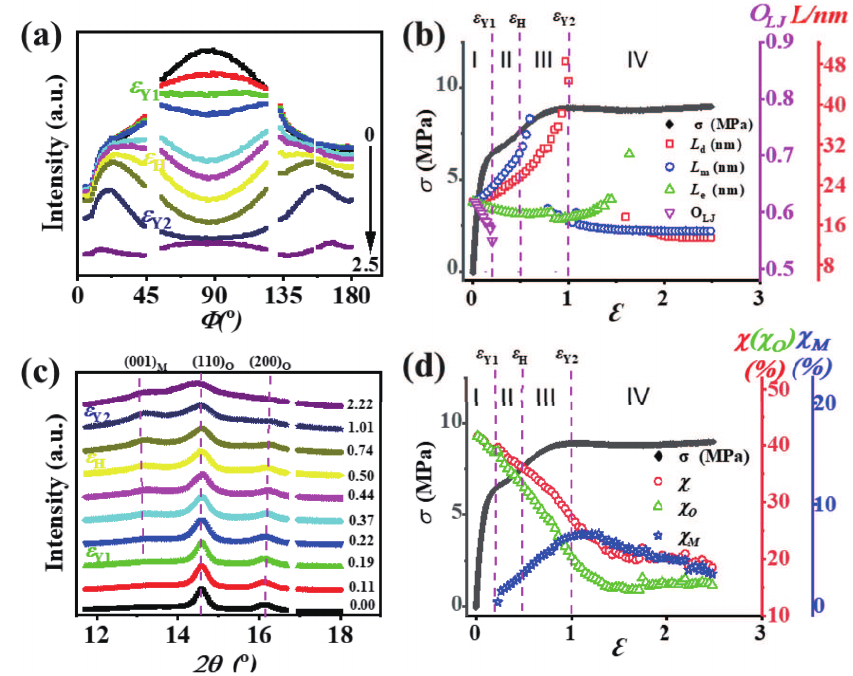
Figure 4. ( a ) Strain dependent SAXS azimuthal integration profiles for PE-61; ( b ) evolution of the long periods along the meridian (blue circles), diagonal (red square), equatorial (green triangle) directions, and the corresponding orientation (pink triangle) as a function of the strain; ( c ) 1D integrated WAXS curves as a function of the strain; ( d ) evolution of the overall crystallinity (red circle), and the relative contents of the monoclinic (blue stars) and the orthorhombic phases (green triangle) as a function of the strain. The engineering stress–strain curve is also plotted for the correlation between the microstructural evolution and mechanical